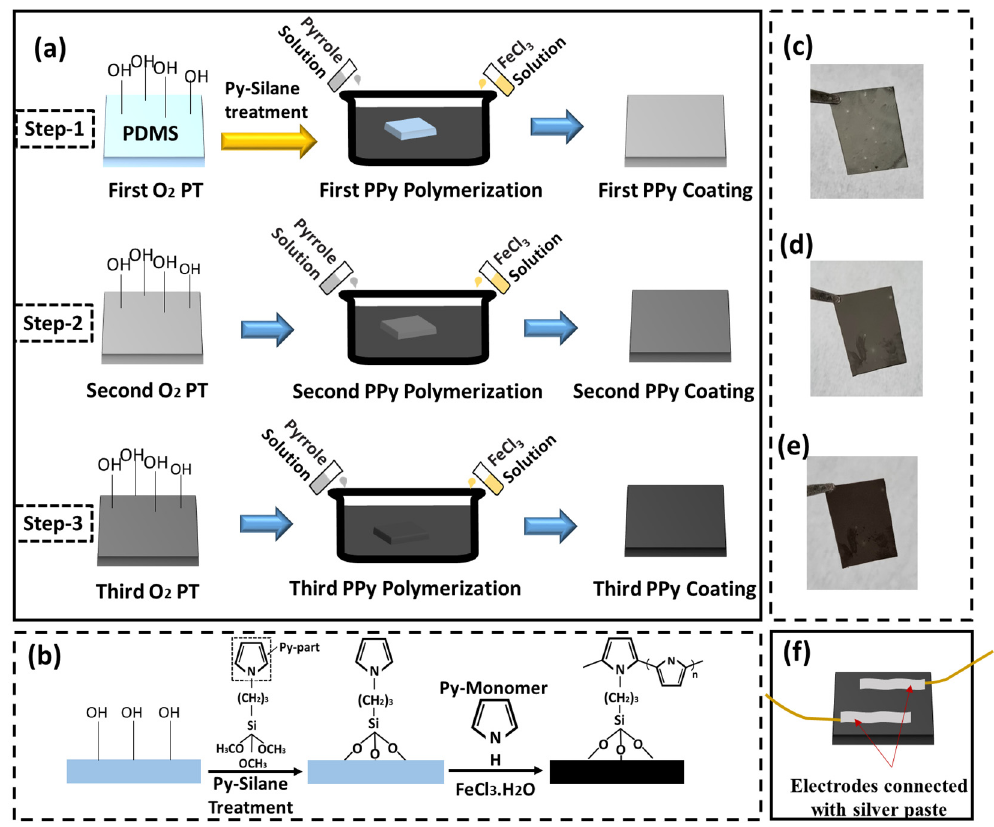
Figure 1. ( a ) Schematic illustrations of the fabrication procedure with O 2 PT for multi-layer PPy/PDMS strain sensors and ( b ) molecular interactions between PPy and PDMS during the film growth. Photographs of the PPy film surfaces after ( c ) first, ( d ) second, and ( e ) third coatings on PDMS substrate and ( f ) the fabricated PPy/PDMS strain sensor with pasted electrodes.